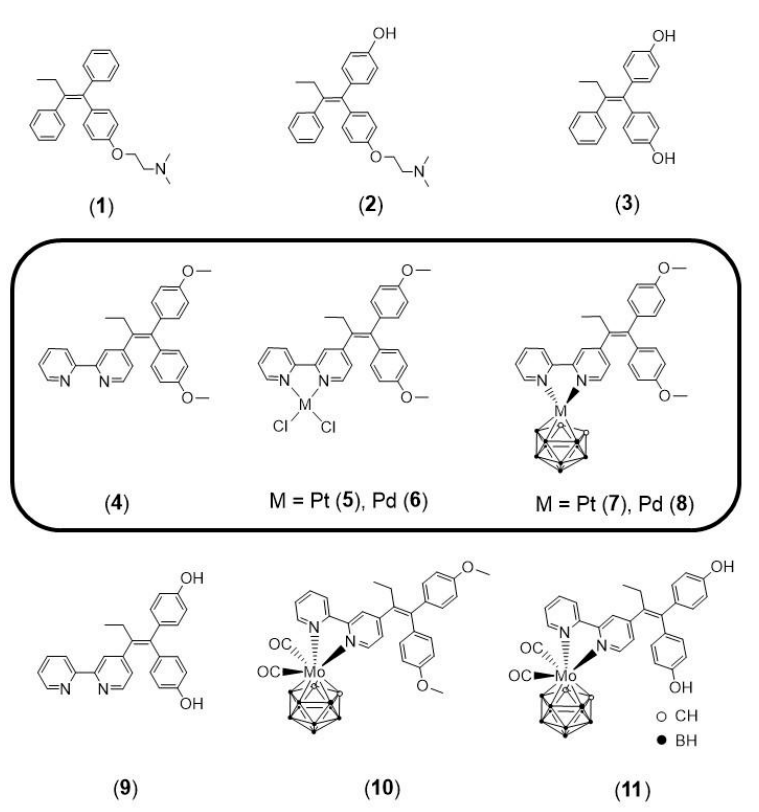
Figure 1. Schematic molecular structures of tamoxifen and tamoxifen-based derivatives: literature- known reference compounds tamoxifen ( 1 ), 4-hydroxytamoxifen ( 2 ), and 4,4 ′ -dihydroxytamoxifen ( 3 ), compounds investigated in this study 4-[1,1-bis(4-methoxyphenyl)but-1-en-2-yl]-2,2 ′ -bipyridine ( 4 , L), [PtCl 2 (L- κ 2 N , N (cid:48) )] ( 5 ), [PdCl 2 (L- κ 2 N , N (cid:48) )] ( 6 ), [3-(L- κ 2 N , N (cid:48) )-3,1,2-PtC 2 B 9 H 11 ] ( 7 ), [3-(L- κ 2 N,N (cid:48) )- 3,1,2-PdC 2 B 9 H 11 ] ( 8 ), as well as previously reported compounds 4-[1,1-bis(4-hydroxyphenyl)but-1- en-2-yl]-2,2 (cid:48) -bipyridine ( 9 , L 1 ), [3-(L- κ 2 N , N (cid:48) )-3-(CO) 2 -3,1,2-MoC 2 B 9 H 11 ] ( 10 ), and [3-(L 1 - κ 2 N , N (cid:48)